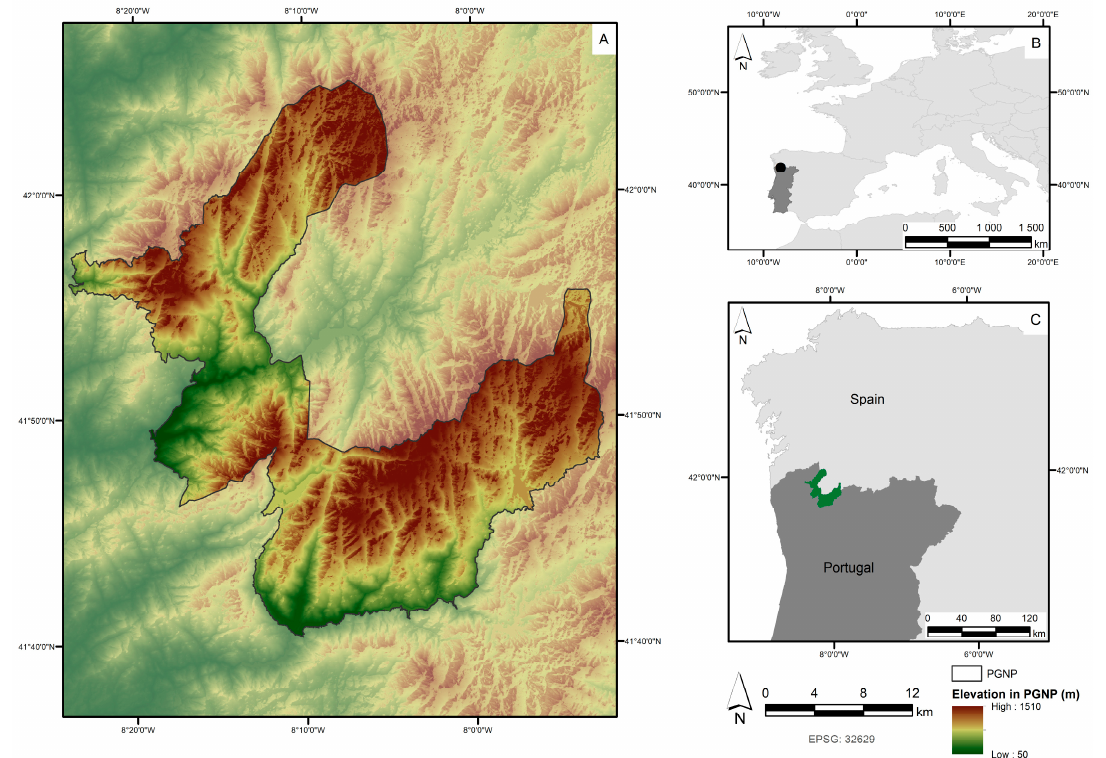
Figure 1. Location of Peneda-Gerês National Park (PGNP). ( A ) Elevation in PGNP based on EU-DEM (European Environmental Agency). ( B ) Portugal and Europe. ( C ) Northern Portugal northwestern Spain.